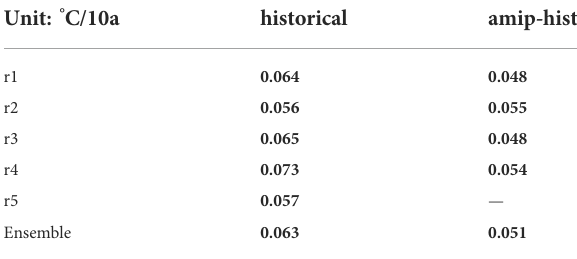
TABLE 5 Same as Table 3, but for the period of 1870 – 2014 with 11- year running average. Unit: °